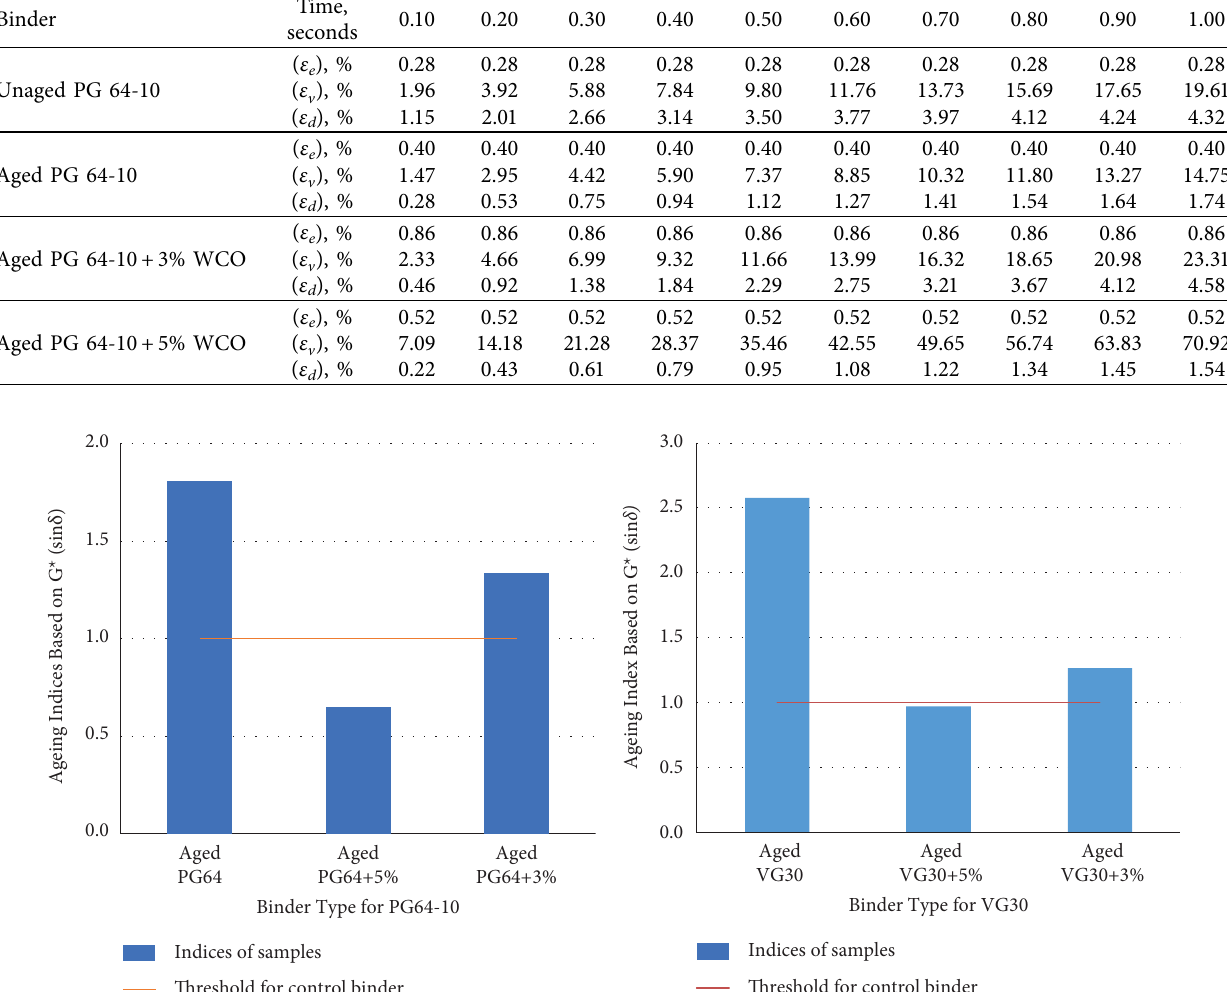
Table 5: Elastic, viscous, and viscoelastic strains for the PG 64-10 binder.